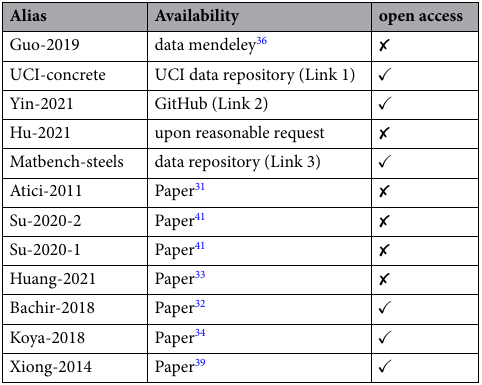
Table 4. Availability of the datasets. Link 1: https:// archi ve. ics. uci. edu/ ml/ datas ets/ concr ete+ compr essive+ stren gth. Link 2: https:// github. com/ Binbi n202/ ML- Data. Link 3: https:// matbe nch. mater ialsp roject.